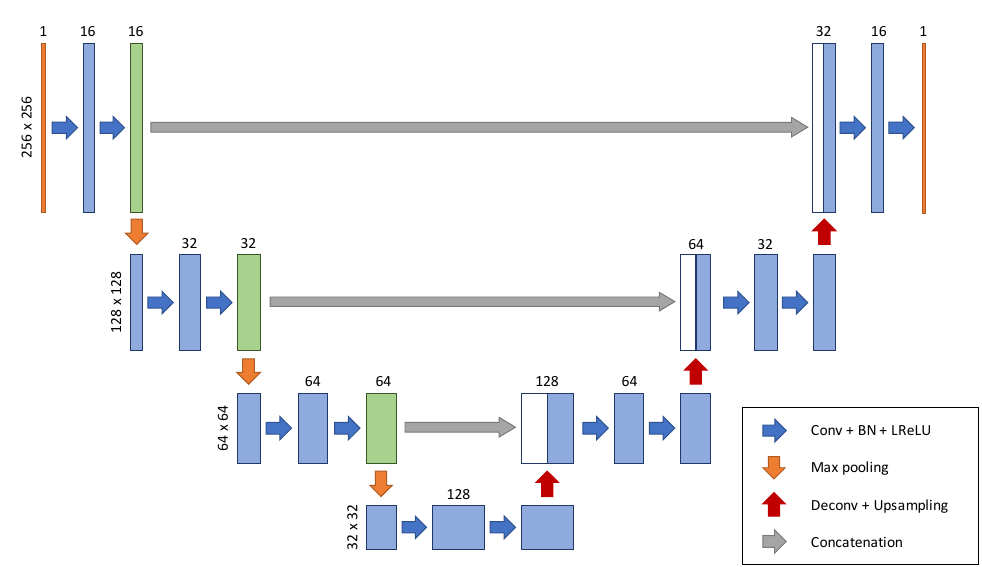
Figure 2. CNN architecture used for representing a priori information in the proposed method. The number of channels is denoted above each box, and pixel sizes appear on the left; arrows denote di ff erent operations.